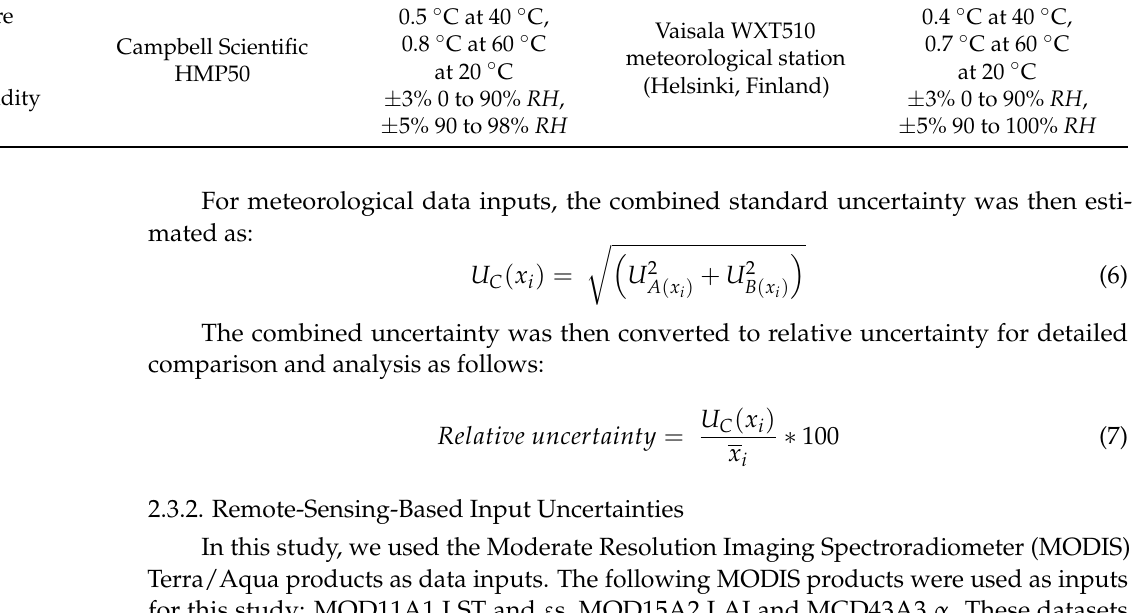
Table 2. Quoted accuracy of meteorological instruments used to measure air temperature ( Tair ) and relative humidity ( RH ) at the two observation sites. Skukuza Welgegund Measurement Sensor Quoted